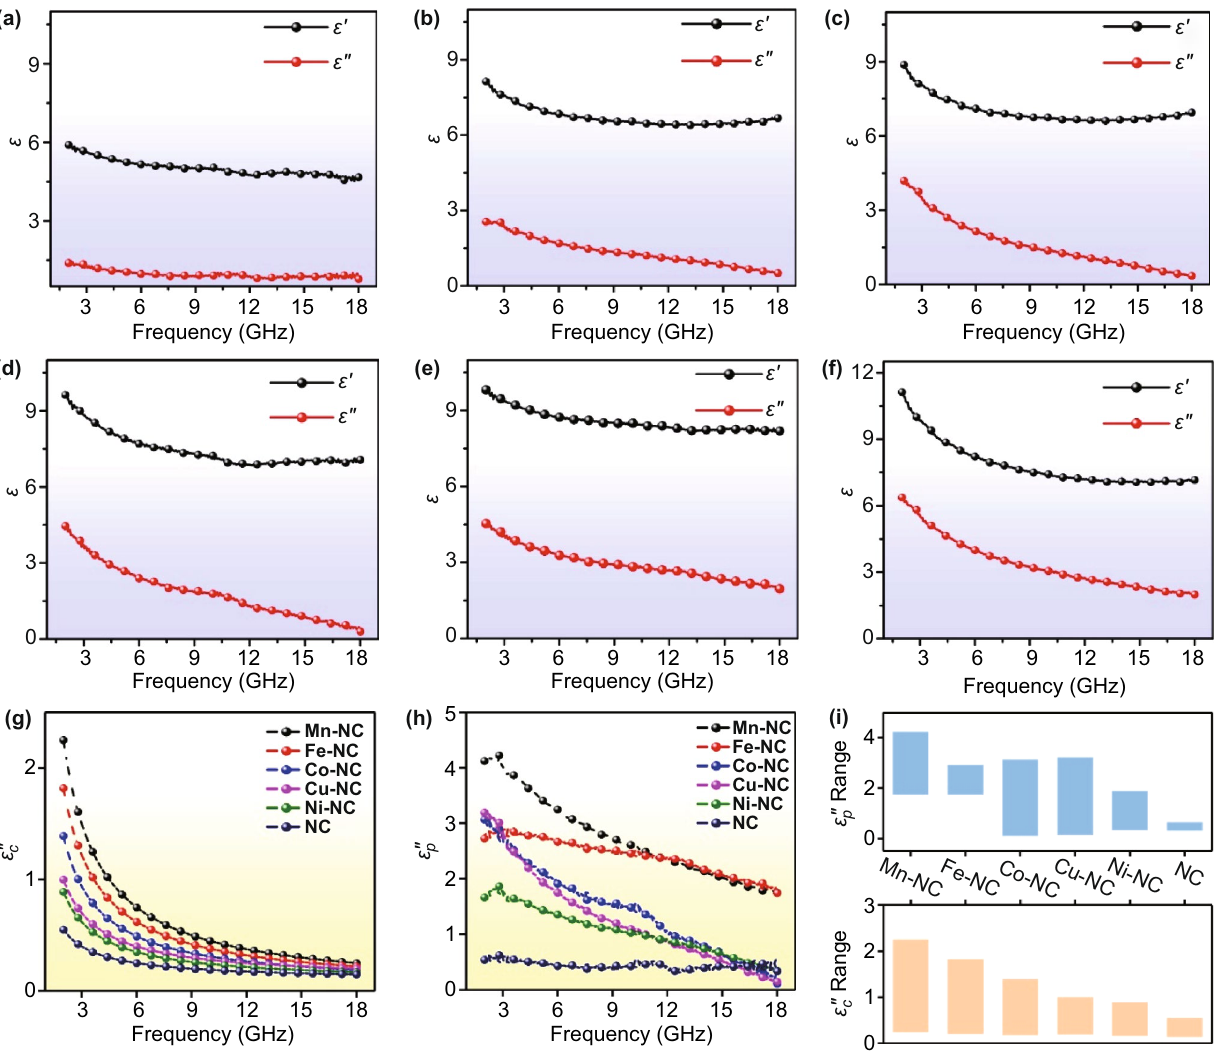
Fig. 5 Frequency dependence of ε r . a 3D NC, b 3D Ni–NC, c 3D Cu–NC, d 3D Co–NC, e 3D Fe-NC, and f 3D Mn–NC. g–h Frequency dependence of ε c ״ and ε p ״ of 3D M–NCs and 3D NC. i The ε c ״ and ε p ״ values of 3D M–NCs and 3D NC cover the range of 2–18